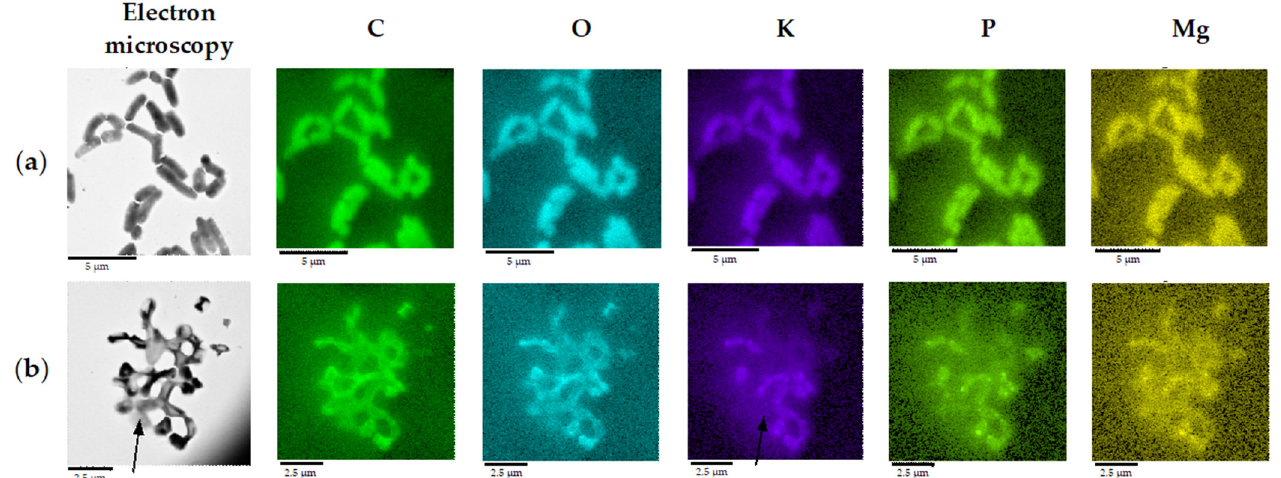
Figure 7. Elemental composition of R. rhodochrous IEGM 757, as determined by mapping using X-ray